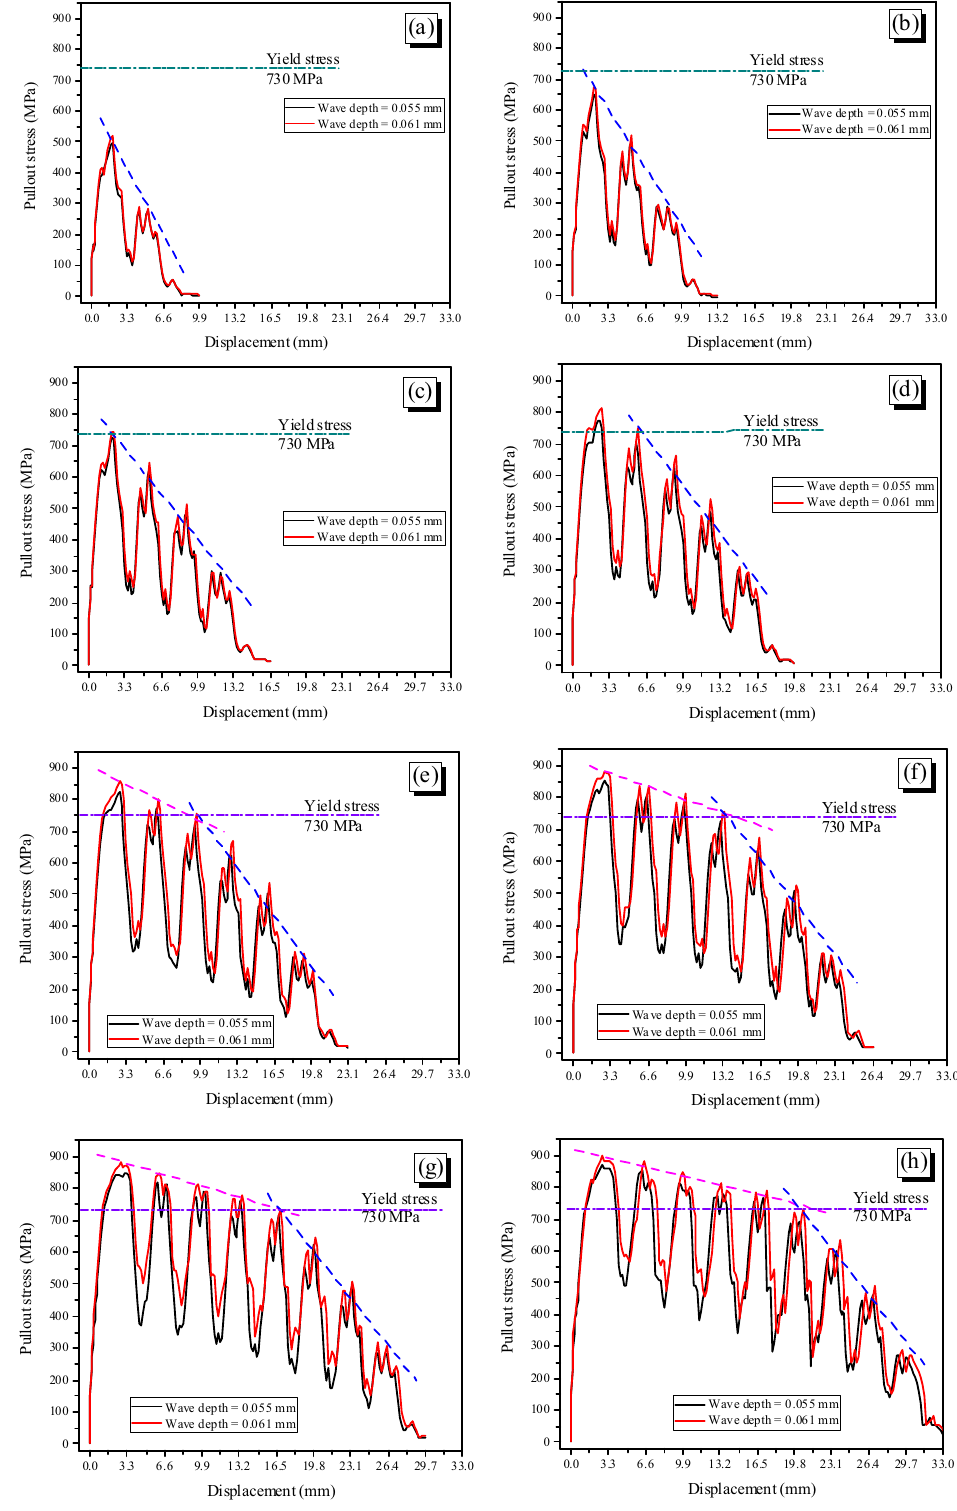
Figure 23: Pullout stress versus slip curves with numbers of waves ranging from 3 to 10: ( a ) 3 waves, ( b ) 4 waves, ( c ) 5 waves, ( d ) 6 waves, ( e ) 7 waves, ( f ) 8 waves, ( g ) 9 waves, and ( h ) 10